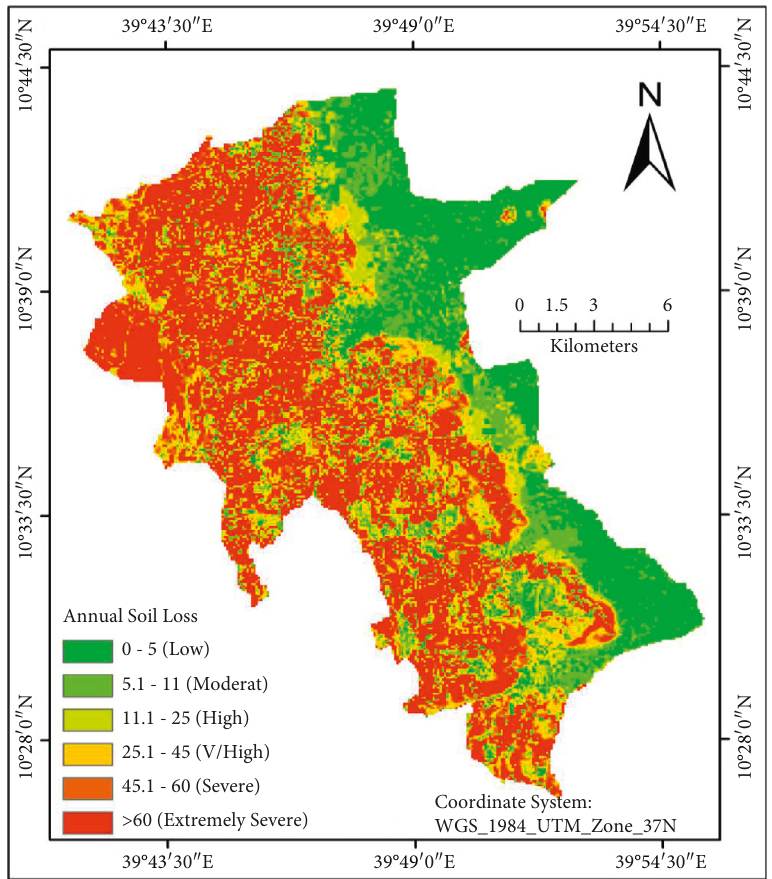
Figure 8: Map of (a) annual soil